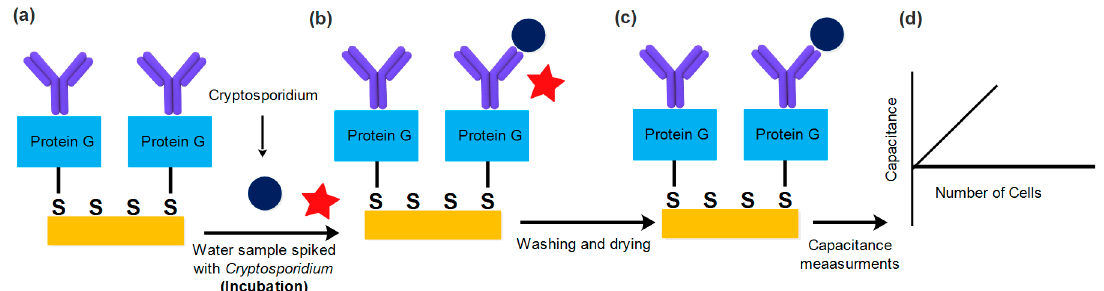
Figure 3. Diagram illustrating the detection process: ( a ) incubation of the anti- Cryptosporidium antibodies by coating the sensing electrodes with water samples containing different concentrations of Cryptosporidium ; ( b ) washing with phosphate-buffered saline (PBS) of pH 7 to remove any unbound and non-specific molecules; ( c ) drying the interdigitated electrodes; and ( d ) capacitance measurements over a specific frequency range.